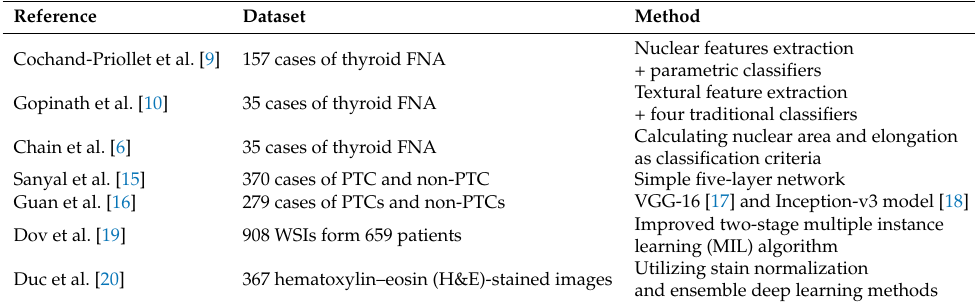
Table 1. General summary of recent